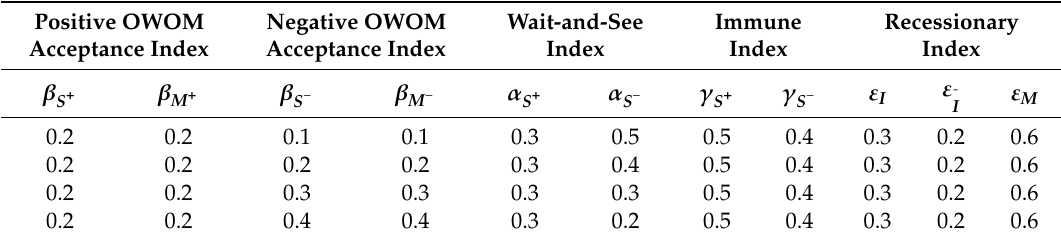
Table 5. Simulation Experiment 2 parameter setting.